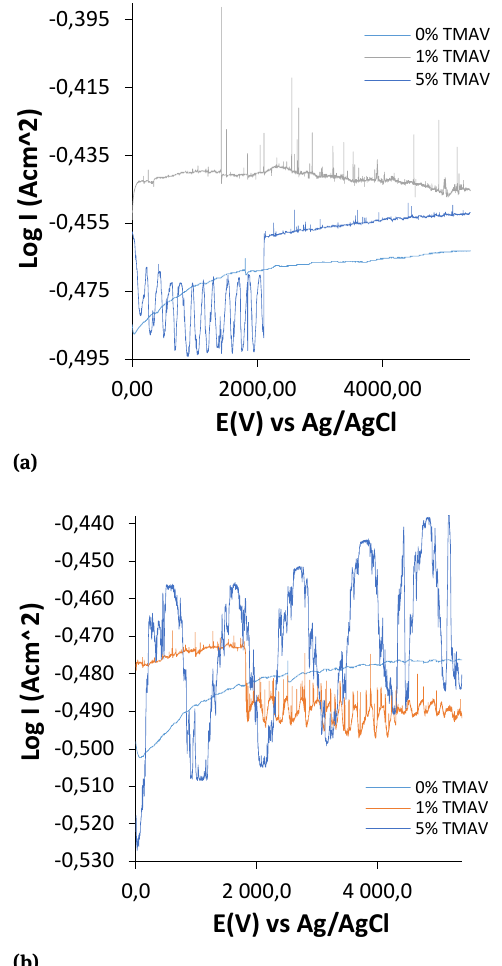
Figure 12: Open circuit potential plots LCS corrosion in (a) H 2 SO 4 solution and (b) HCl solution at 0%, 1% and 5% TMAV